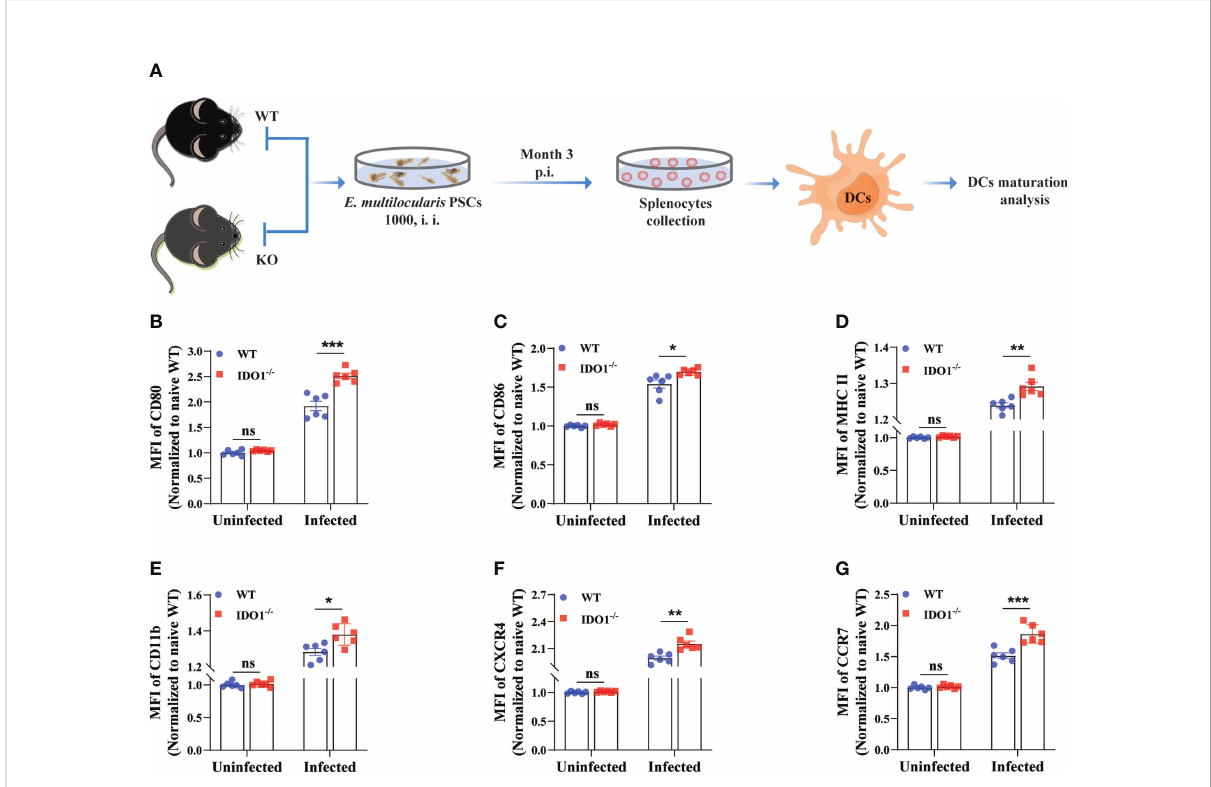
FIGURE 3 IDO1 signaling limits DCs maturation in mice infected with E multilocularis . (A) Schematic representation of the experimental setup. (B – G) Quanti fi cation of the relative intensity of CD80, CD86, MHCII, CD11b, CXCR4, and CCR7 within splenic DCs of the IDO1 -/- and WT mice at 3 months post-infection with E multilocularis (n = 6/group). CD45 + MHC II + CD11c + cells were gated. Data are pooled from 2 independent experiments, and presented as the mean ± SEM. ns, not signi fi cant; *, p< 0.05; **, p < 0.01; ***, p < 0.001. PSCs, protoscoleces; p.i., post infection; i.i., injected